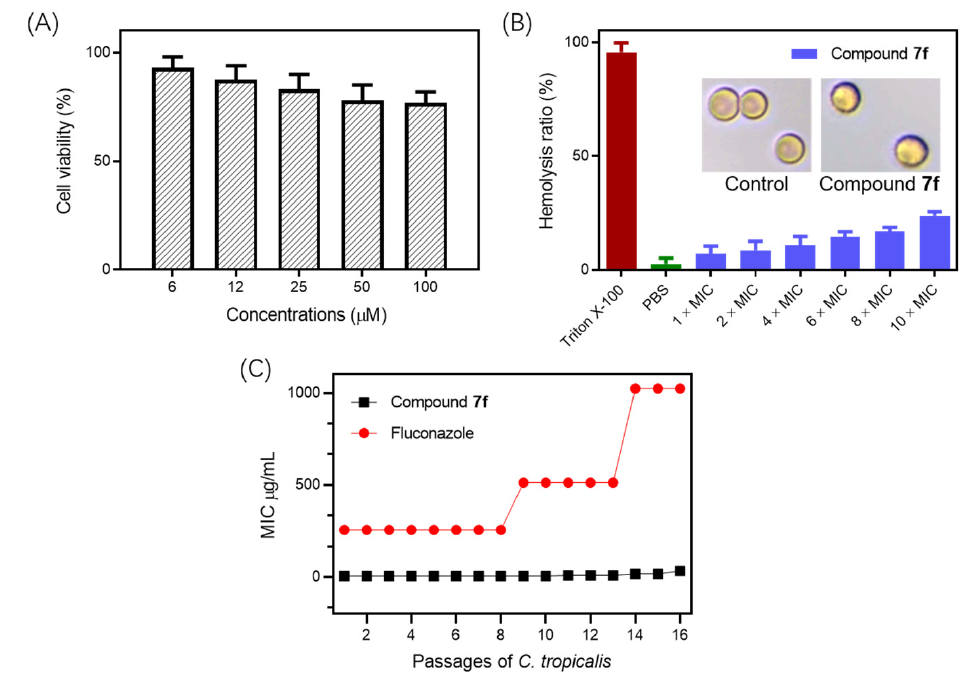
Figure 4. ( A ) Cell viability of LO2 cell treated by thioether benzimidazole 7f ; ( B ) The hemolysis ratio of human red blood cell caused by positive control (Triton X-100), negative control (PBS) and 7f at 1 × , 2 × , 4 × , 6 × , 8 × and 10 × MIC, respectively. Inset: Photographs of red blood cells treated with PBS and compound 7f (1 × MIC); ( C ) Resistance development of thioether benzimidazole 7f and fluconazole against C. tropicalis.